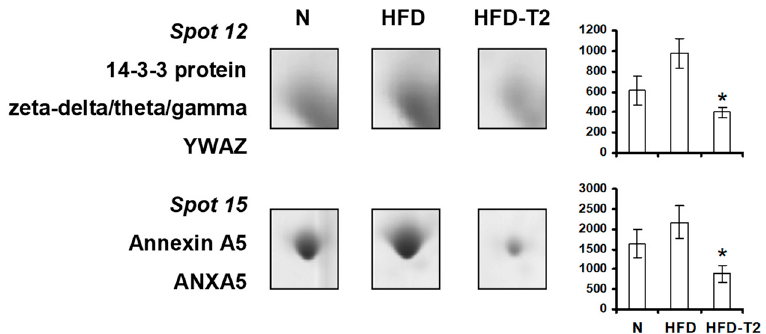
Figure 8. Four-week 3,5-T2 treatment-associated differential representation within the VAT proteome with regard to signaling and cellular structure proteins. Representative subsections of 2D-E images of VAT of N, HFD, HFD-T2 rats. Results are expressed as arbitrary units (means ± SEM; n = 4). * p < 0.05 vs. HFD. Spot numbering refers to Figure 5a.